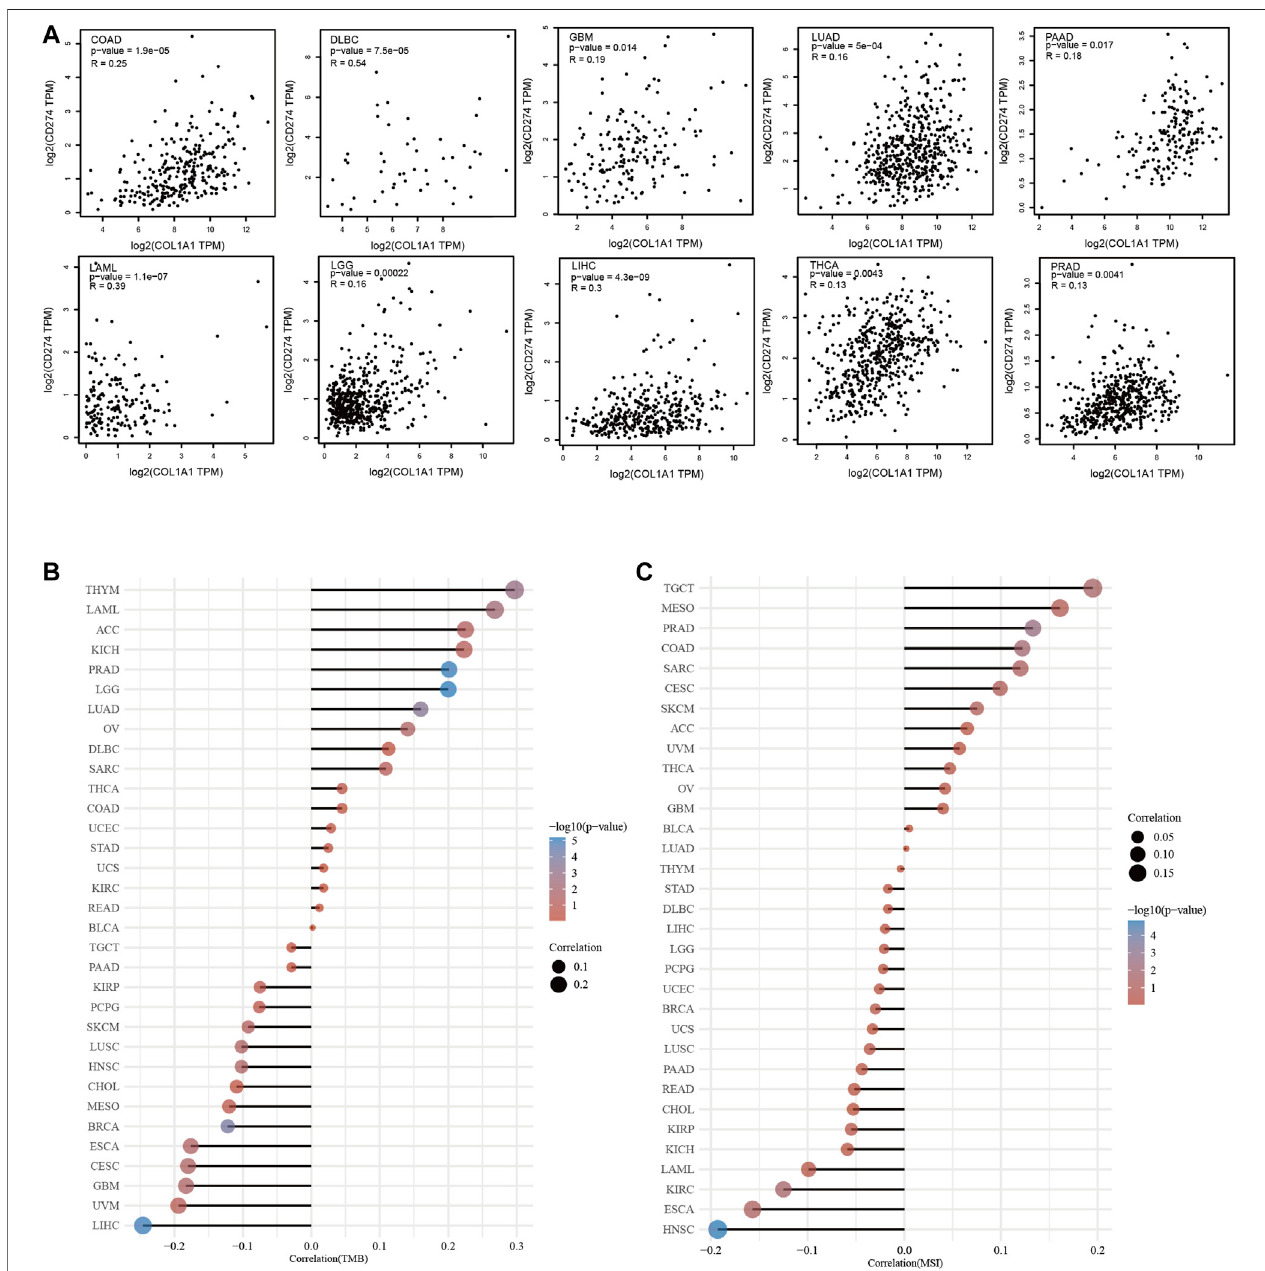
representsthecorrelation coef fi cientbetweengenesand TMB/MSI,theordinateisdifferenttumors,thesizeofthedotsinthe fi gurerepresentsthesizeofthecorrelation coef fi cient, and the different colors represent the signi fi cance of the p value. The bluer the color, the smaller the p value.